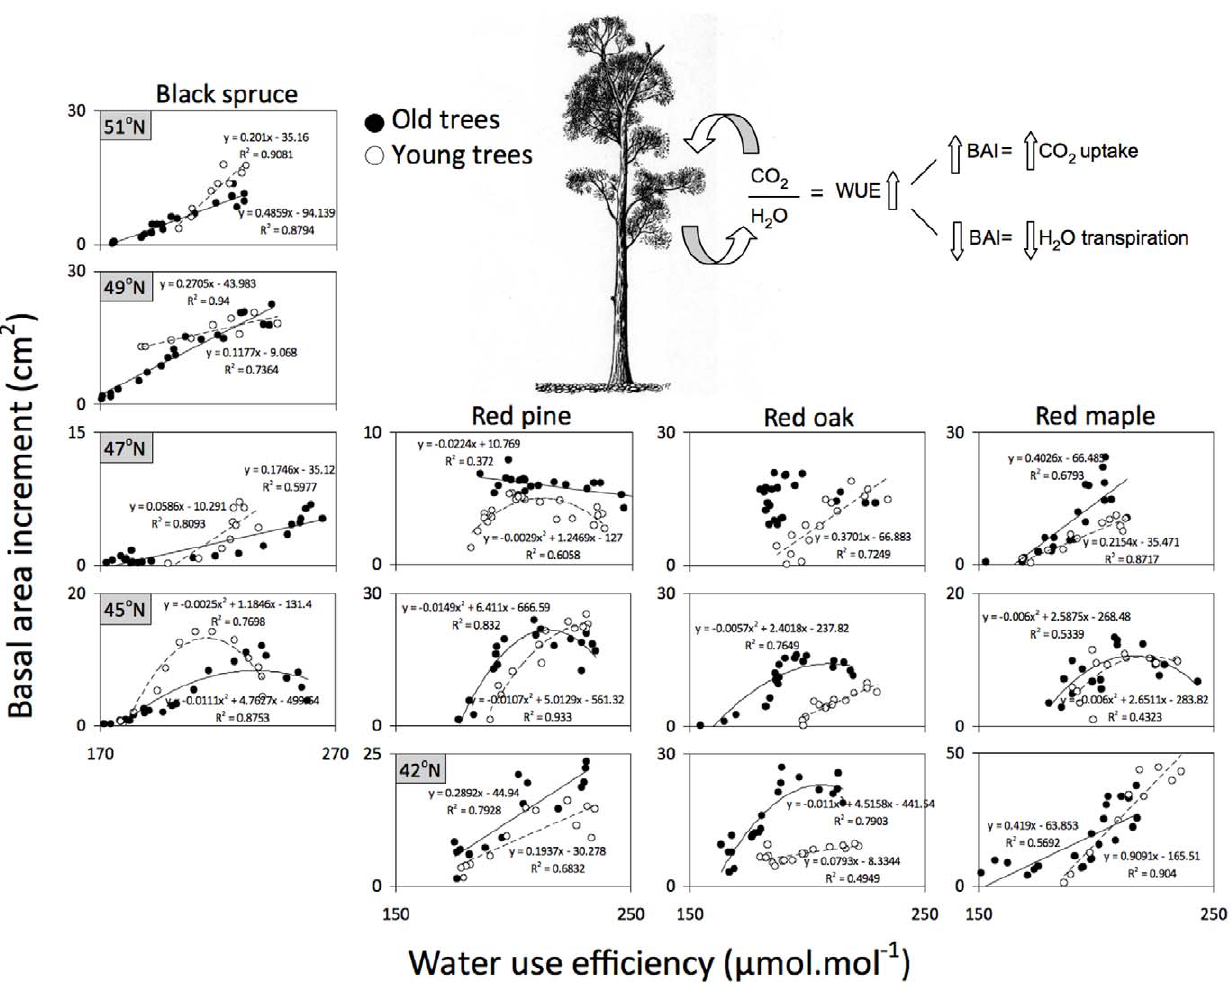
Figure 3. Correlations between water use efficiency (WUE) and basal area increment (BAI) for the five youngest (white circles) and five oldest (black circles) trees during the past century. WUE values were obtained from 5-year pooled rings and BAI values represent 5-year increment averages. Solid lines show significant correlation for old trees and dashed lines significant correlations for young trees (P , 0.05). Positive linear relationships correspond to greater carbon uptake, while polynomial functions correspond to water stress.